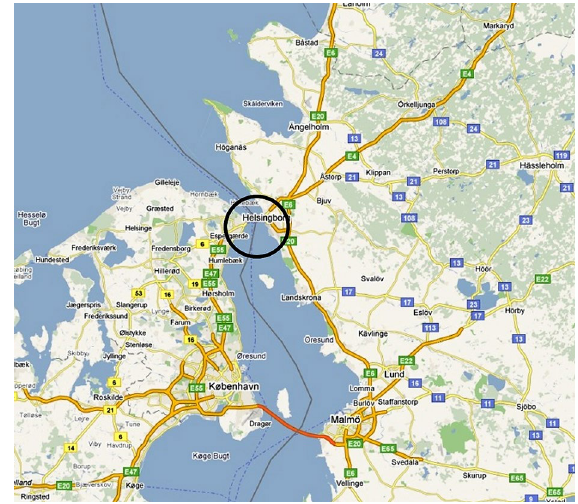
Fig. 1. The proposed new fixed link between Elsinore (Helsingor – Denmark) and Helsingborg (Sweden): the HH-Connection (from Google